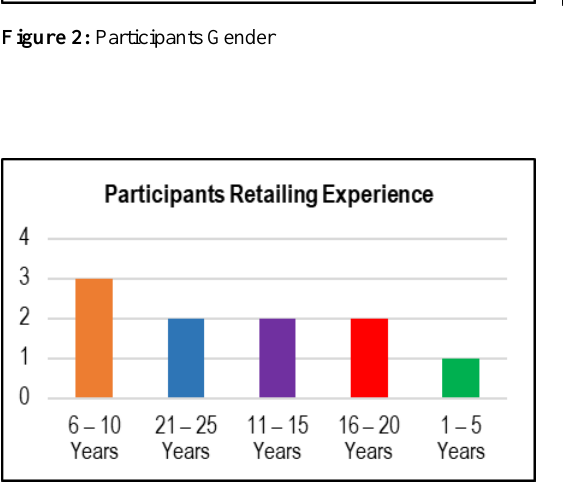
Figure 4: Participants Retailing Experience Figure 5: Participants Location